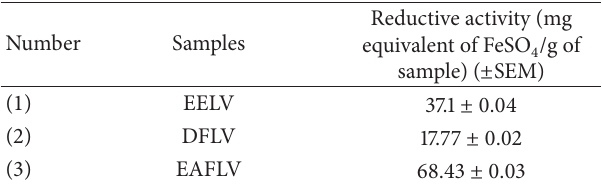
Table 1: The content of total phenol and flavonoids of the ethanolic extract and fractions of L. venustum .